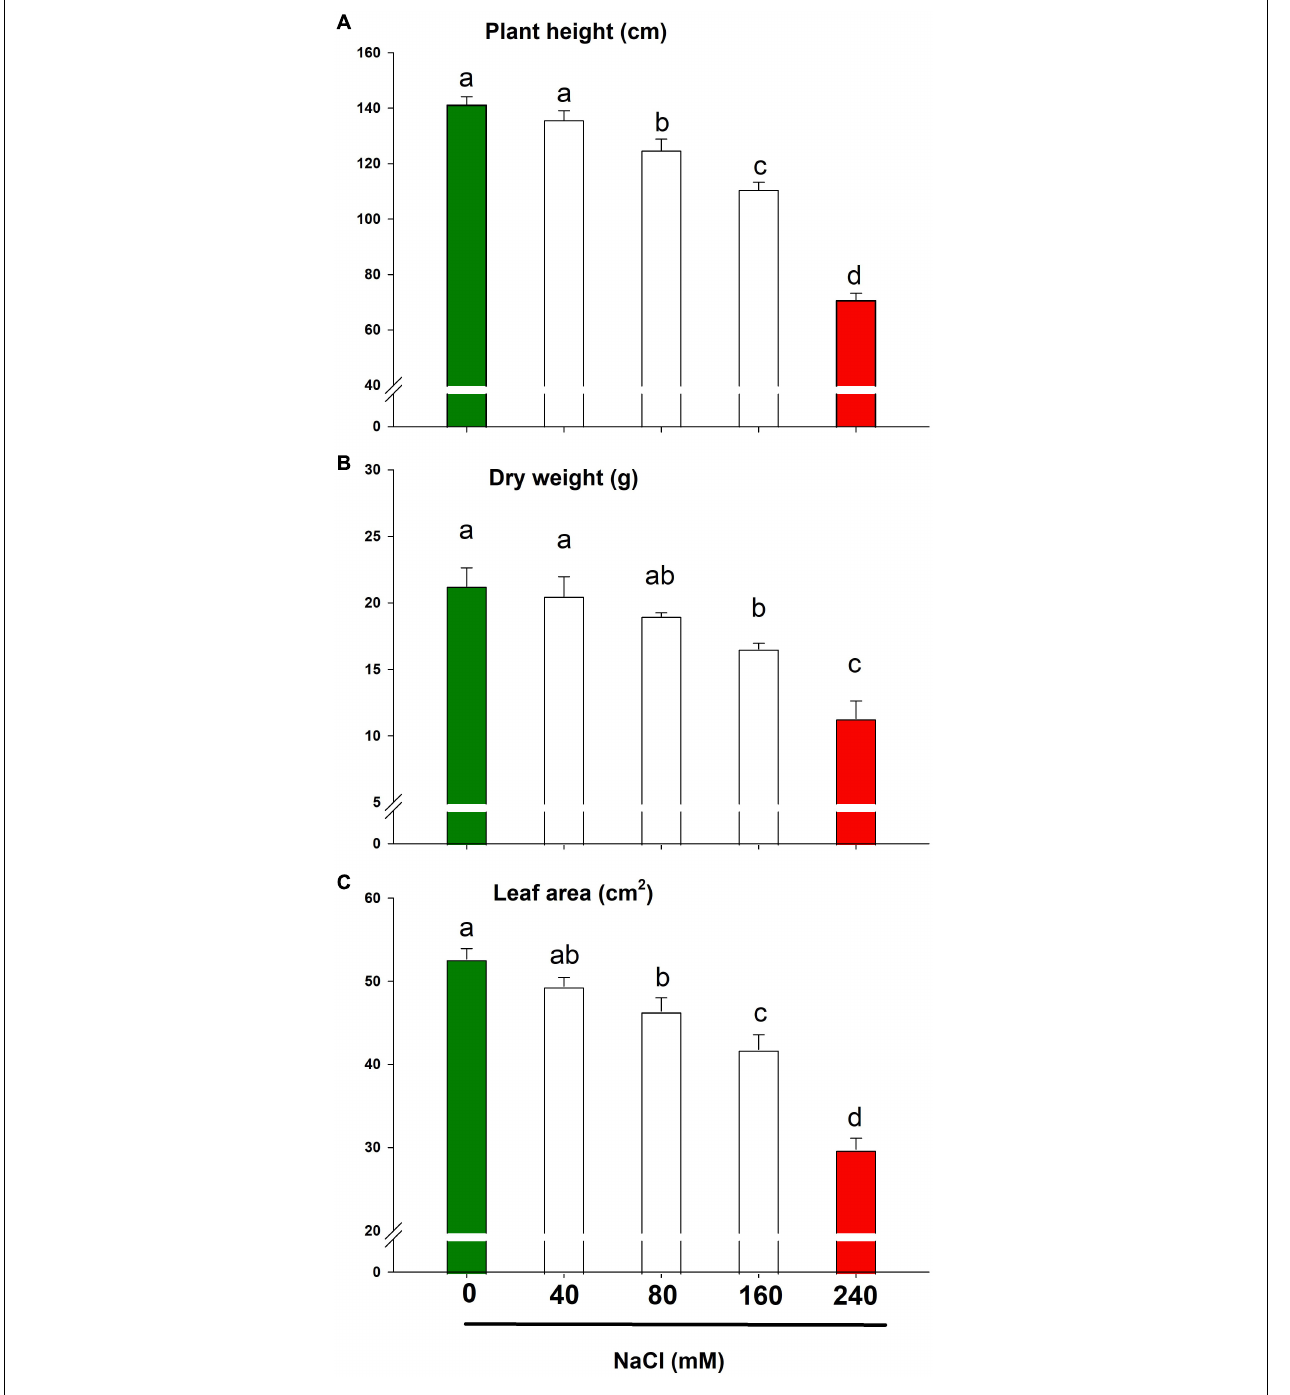
FIGURE 3 | Growth parameters of lemongrass plant under the different salt regimes (0, 40, 80, 160, and 240 mM NaCl) depicting plant height (A) , dry weight (B) , and leaf area (C) . Each bar represents mean ± SE ( n = 3). Means followed by the same letter(s) do not differ by LSD test at 5% probability level ( α = 0.05). The colors are just visual ques for readers to quickly distinguish between control and most stressed treatment.